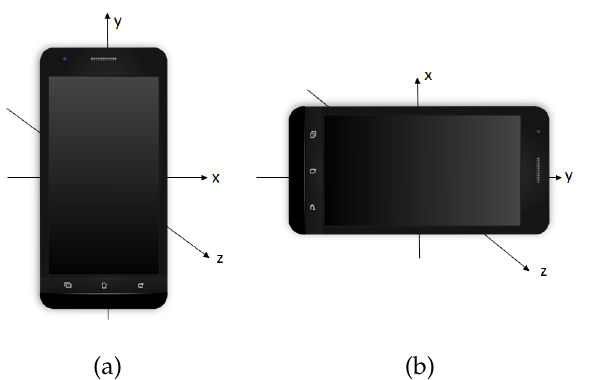
Figure 1. Representation of the three axes into which the accelerations are measured; and shown in two different positions, panels ( a ) and ( b ).